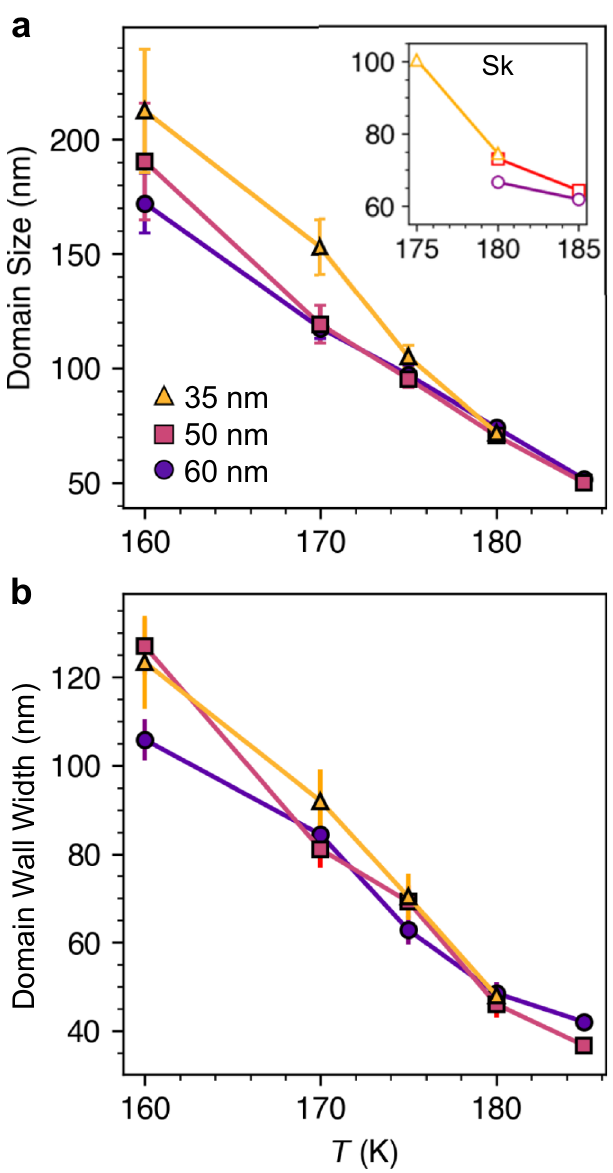
Fig. 4 Domain size and domain wall width as a function of temperature and sample thickness. a The stripe domain size, determined from the x-ray microscopy images at 0 mT following the fi eld sweep protocol, as a function of temperature for each sample thickness. The inset plots the average diameters of the skyrmions (Sk) over all fi elds as a function of temperature for each sample thickness. b The domain wall width of stripe domains determined at 0 mT as a function of temperature for each sample thickness. Error bars indicate the standard error of all domains sizes/widths averaged at each fi eld and temperature